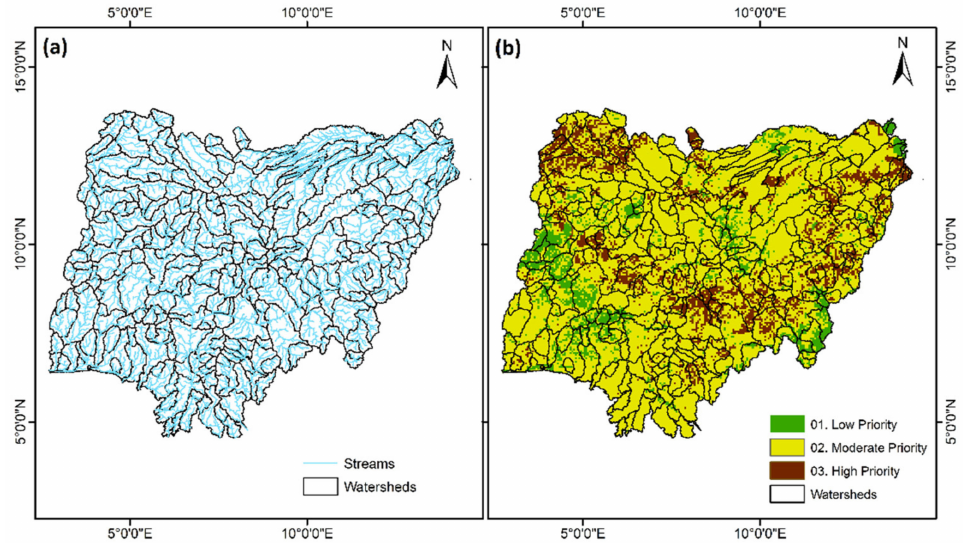
Figure 9. ( a ) Watershed and stream network delineation in Nigeria. ( b ) Spatial distribution of watersheds and their priority in Nigeria.